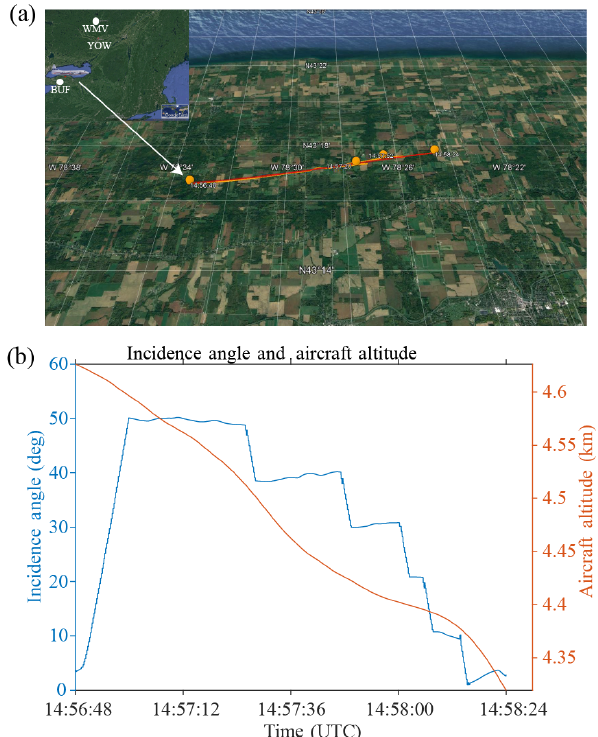
Figure 14. Flight track and beam configuration during the PDPP data collection on 25 March 2017. (a) The NRC Convair-580 flight track (red) and the radar beam ground-track (orange). The locations of the two radiosonde stations, Buffalo, NY (BUF) and Maniwaki, Quebec (WMV) and Ottawa (YOW) are also shown to aid the in- terpretation of the data presented in Fig. 13. (b) Aft-antenna beam incidence angle and aircraft